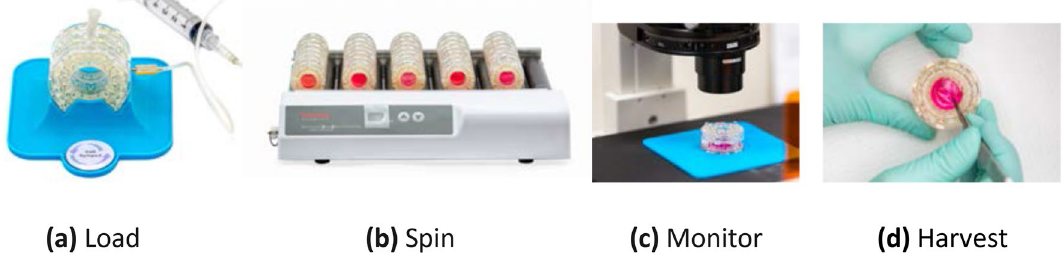
Figure 2. Loading, spinning, monitoring, and harvesting cell spinpods. ( a ) Cells and media are loaded into the cell spinpod, held in a 3D-printed loading dock (blue), with a needle in one port and an air bleed needle in the second self-sealing port. (See also Supplemental video 2). ( b ) Cell Spinpods are spun on an ordinary laboratory bottle roller so that contents are maintained under laminar flow conditions. (See also Supplemental video 1). ( c ) Cells can be monitored in situ still within the Cell Spinpod by microscopy through the optically clear gas exchange membranes when placed in the microscopy holder (blue), which places the cell spinpod’s cellular contents in the focal length of most inverted microscopes. ( d ) Cells can be harvested by incising the membrane or through a needle inserted in the ports. Photographs and videos were taken by author Cells.